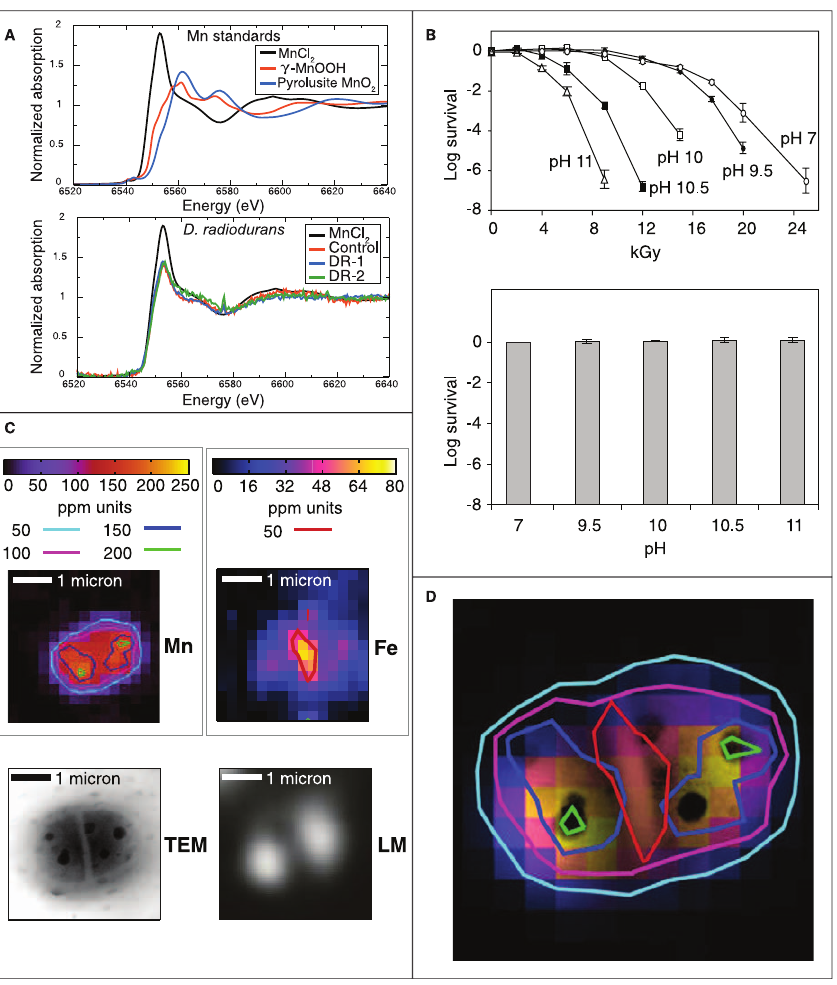
Figure 6. IR Resistance and Mn Profiles of D. radiodurans (A) XANES absorption spectra. Top, Mn standards: MnCl 2 (Mn(II)), c -MnOOH (Mn(III)), and MnO 2 (Mn(IV)). Bottom, D. radiodurans . Control: No IR, analyzed frozen ( (cid:3) 14 8 C). DR-1: þ 10 kGy ( (cid:3) 78 8 C), analyzed frozen ( (cid:3) 14 8 C). DR-2: þ 10 kGy ( (cid:3) 78 8 C), analyzed thawed (5 8 C). (B) pH-dependent IR survival of D. radiodurans . Top, cells were grown in TGY (pH 7), irradiated ( 60 Co) in TGY (0 8 C) at the indicated pH, neutralized, and then recovered on TGY (pH 7). Bottom, survival of non-irradiated D. radiodurans grown in TGY (pH 7), then held in TGY (0 8 C) at the indicated pH for 16 h, neutralized, and then plated on TGY (pH 7). IR survival assays as described previously [1]. (C) XRF elemental distribution maps of Mn and Fe in D. radiodurans . The D. radiodurans diplococcus (designation: no. 109) was isolated from the mid- logarithmic growth phase (OD 600 0.3). For additional XRF microprobe analyses (P, Cl, Mn, Fe, Co, Ni, and Cr), see Figure S3. (D) Transparent image overlay of TEM, LM, and XRF measurements, and ppm contour lines displayed in